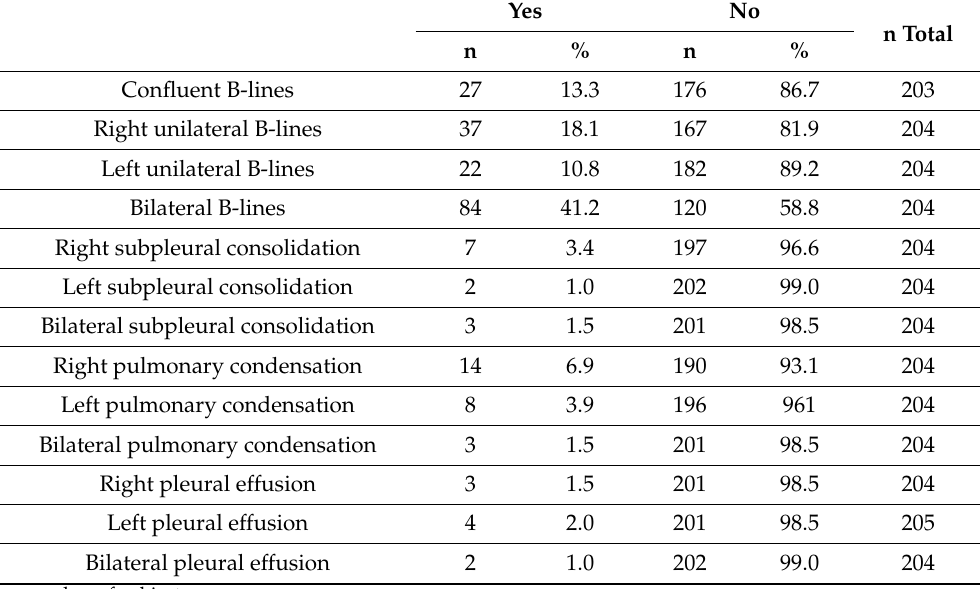
Table 2. Analysis of lung ultrasound characteristics.